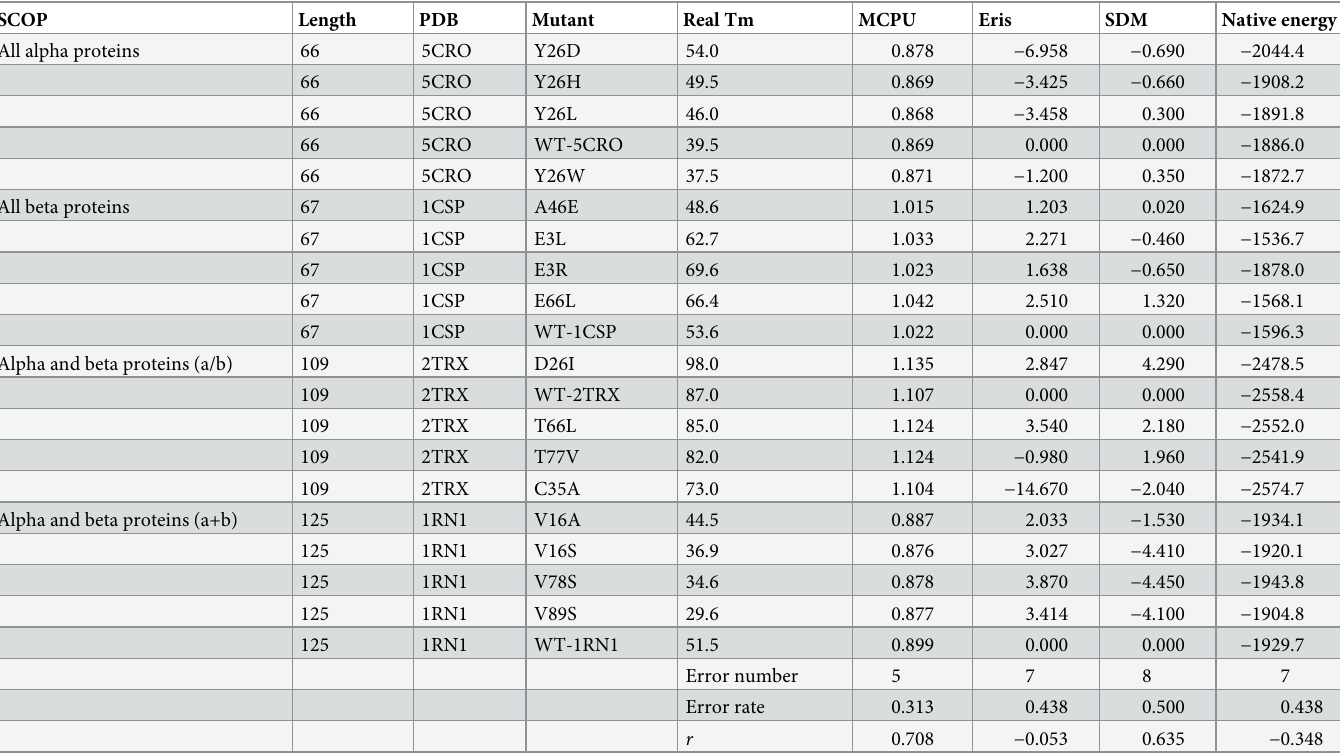
Table 2. Simulation results on non-DHFR